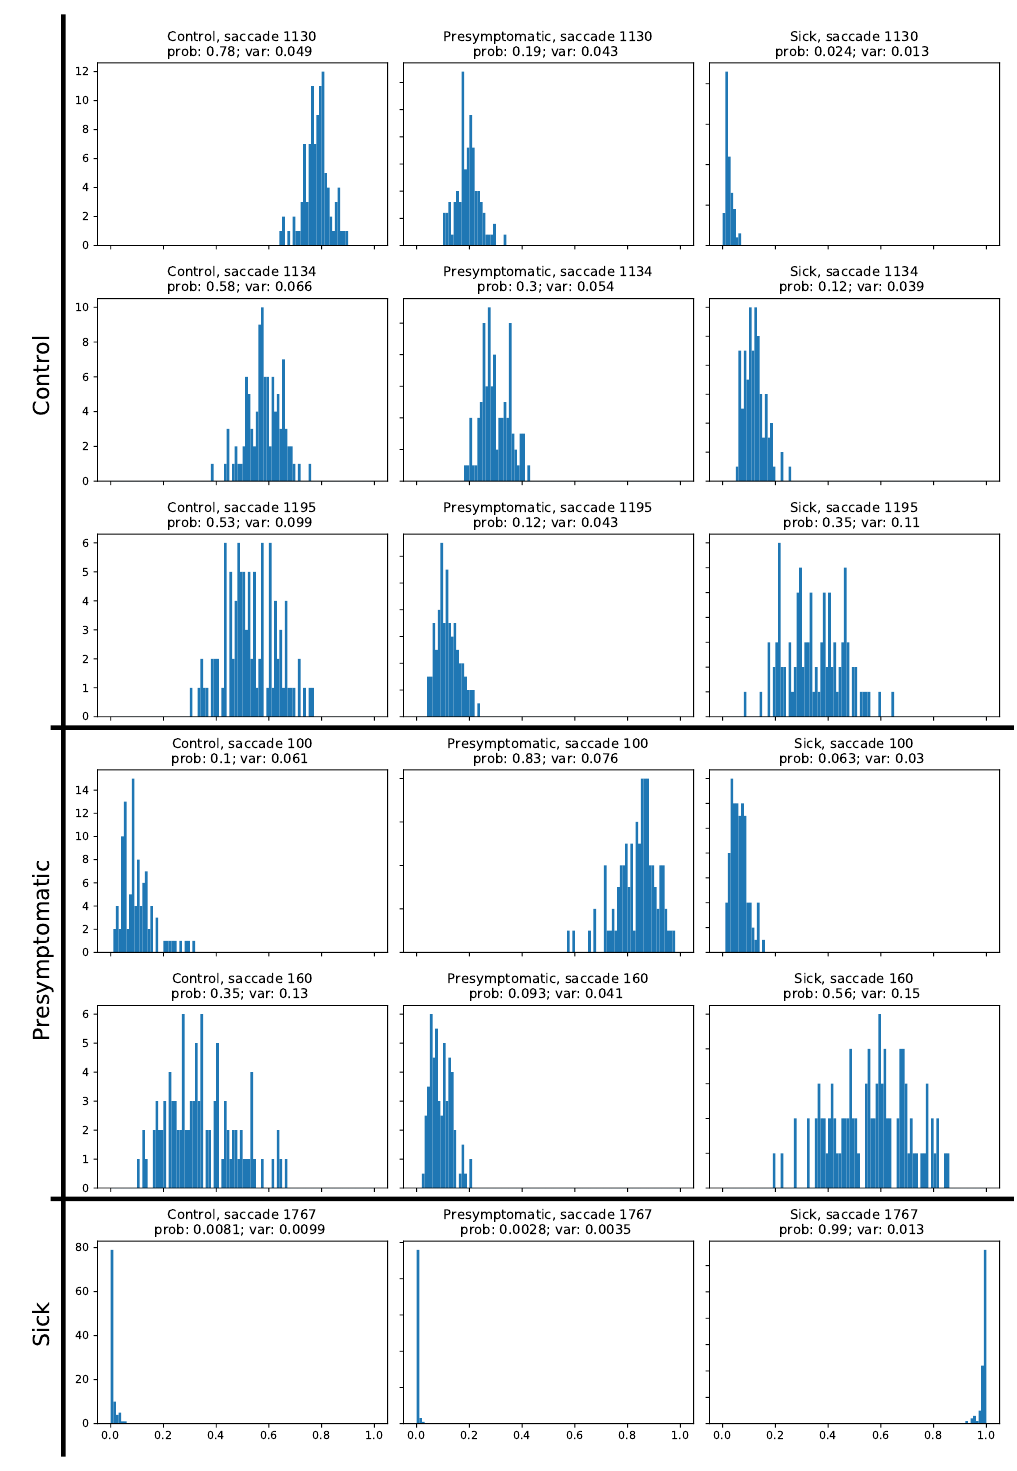
Figure 4. Example of the classification probabilities and variances from the 100 MCD runs for some saccades from class control (3 saccades in register C029, rows 1–3), from class presymptomatic (2 samples from register P022, rows 4–5) and from class sick (1 saccade from register S021, last